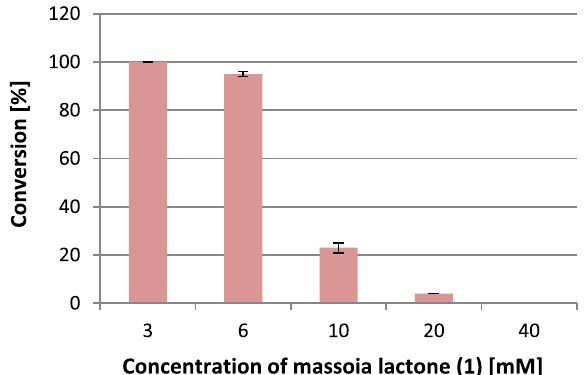
Figure 5. Conversion of massoia lactone ( 1 ) with immobilized cells of E. coli BL21(DE3)/pET30a-OYE3 in batch mode with different concentration of substrate 1 (4 h reaction time).